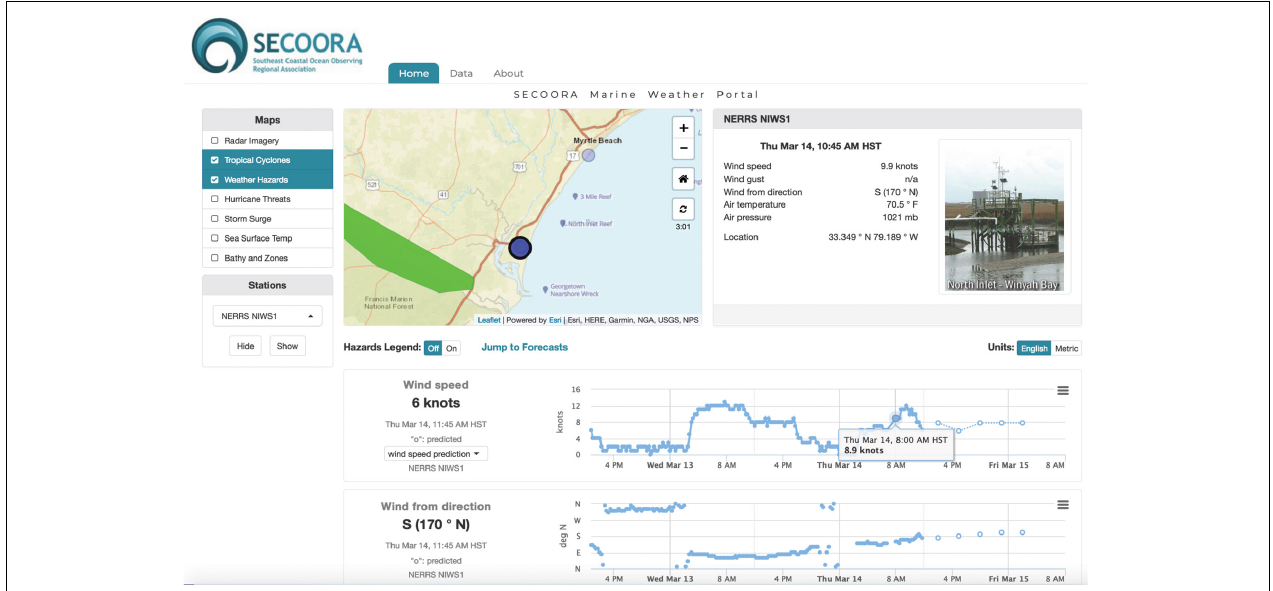
FIGURE 10 | The SECOORA Marine Weather Portal map interface allows users to toggle on/off layers (e.g., weather hazards, sea surface temperatures, and hurricane threats). The dots on the map represent real-time stations (e.g., buoys, water level stations) that users can click on to see recent observations and forecasts for that location. Individual station pages, such as shown in this figure, allow users to graph the most recent data and observe trends in the weather and sea state data. Image courtesy of SECOORA.